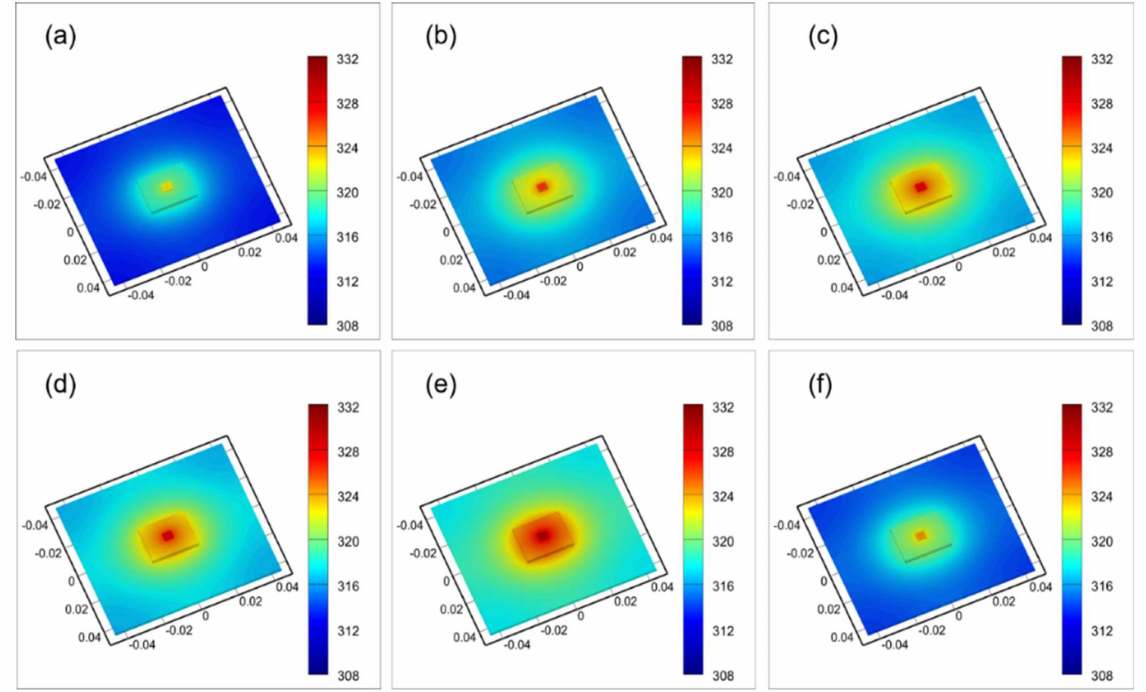
Figure 6. Surface temperature distribution of the receiver. ( a ) Z = 108 mm; ( b ) Z = 109 mm; ( c ) Z = 110 mm (focal plane); ( d ) Z = 111 mm; ( e ) Z = 112 mm; ( f ) Z = 114